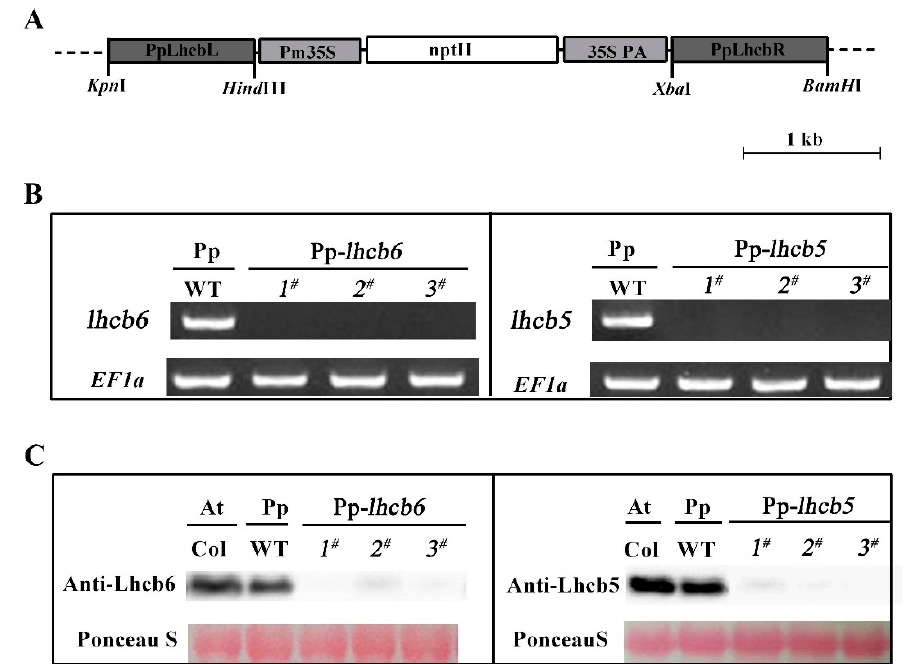
Figure 1. The identification of knock-out mutants. ( A ) The plasmid vector’s schematic maps of pTN182- PpLhcb5/6 used for knock-out a generation. ( B ) The expression of PpLhcb6 and PpLhcb5, in wild-type and knock-out mutants, was analyzed by RT-PCR. ( C ) Immunoblotting of Lhcb6 and Lhcb5 from Arabidopsis (Col) and Physcomitrella (wild-type (WT) and lines of knock-out mutants). The chlorophyll content of every lane was 15 μ g. Proteins were stained with Ponceau S and Rubisco proteins were used as loading controls.